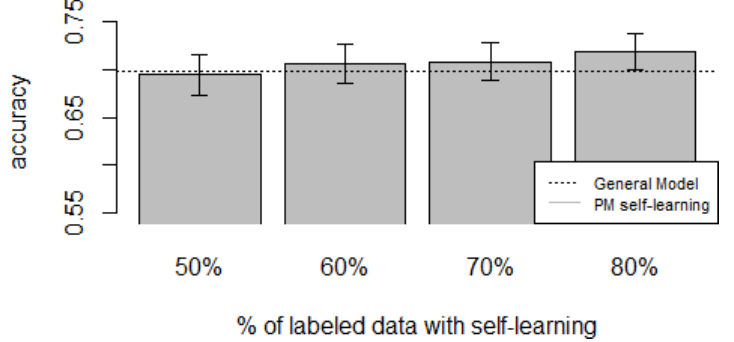
Figure 11. D2: Wrist sensor dataset bar plot for different % of labeled data with self-learning.